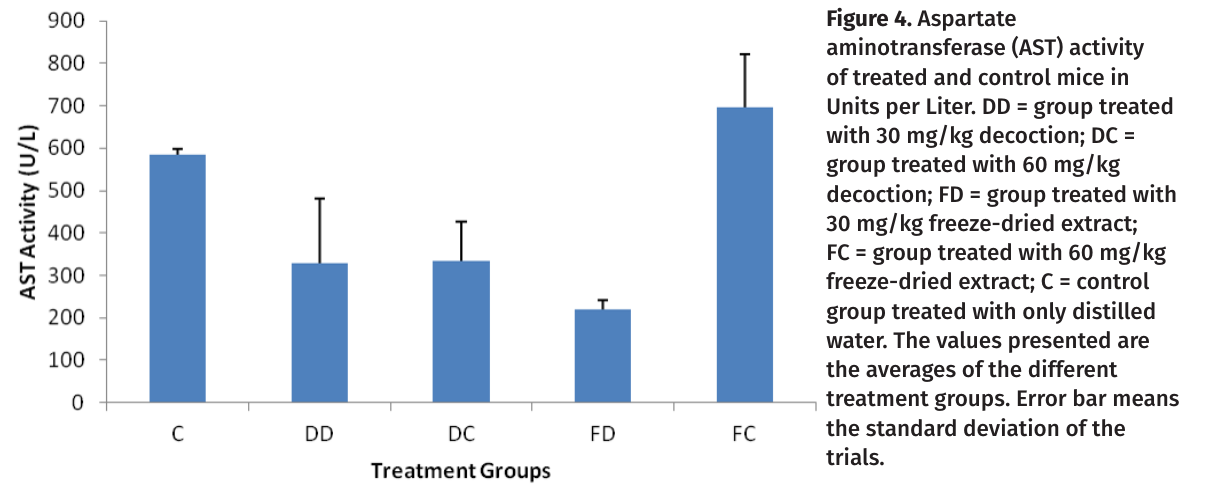
Figure 4. Aspartate aminotransferase (AST) activity of treated and control mice in Units per Liter. DD = group treated with 30 mg/kg decoction; DC = group treated with 60 mg/kg decoction; FD = group treated with 30 mg/kg freeze-dried extract; FC = group treated with 60 mg/kg freeze-dried extract; C = control group treated with only distilled water. The values presented are the averages of the different treatment groups. Error bar means the standard deviation of the